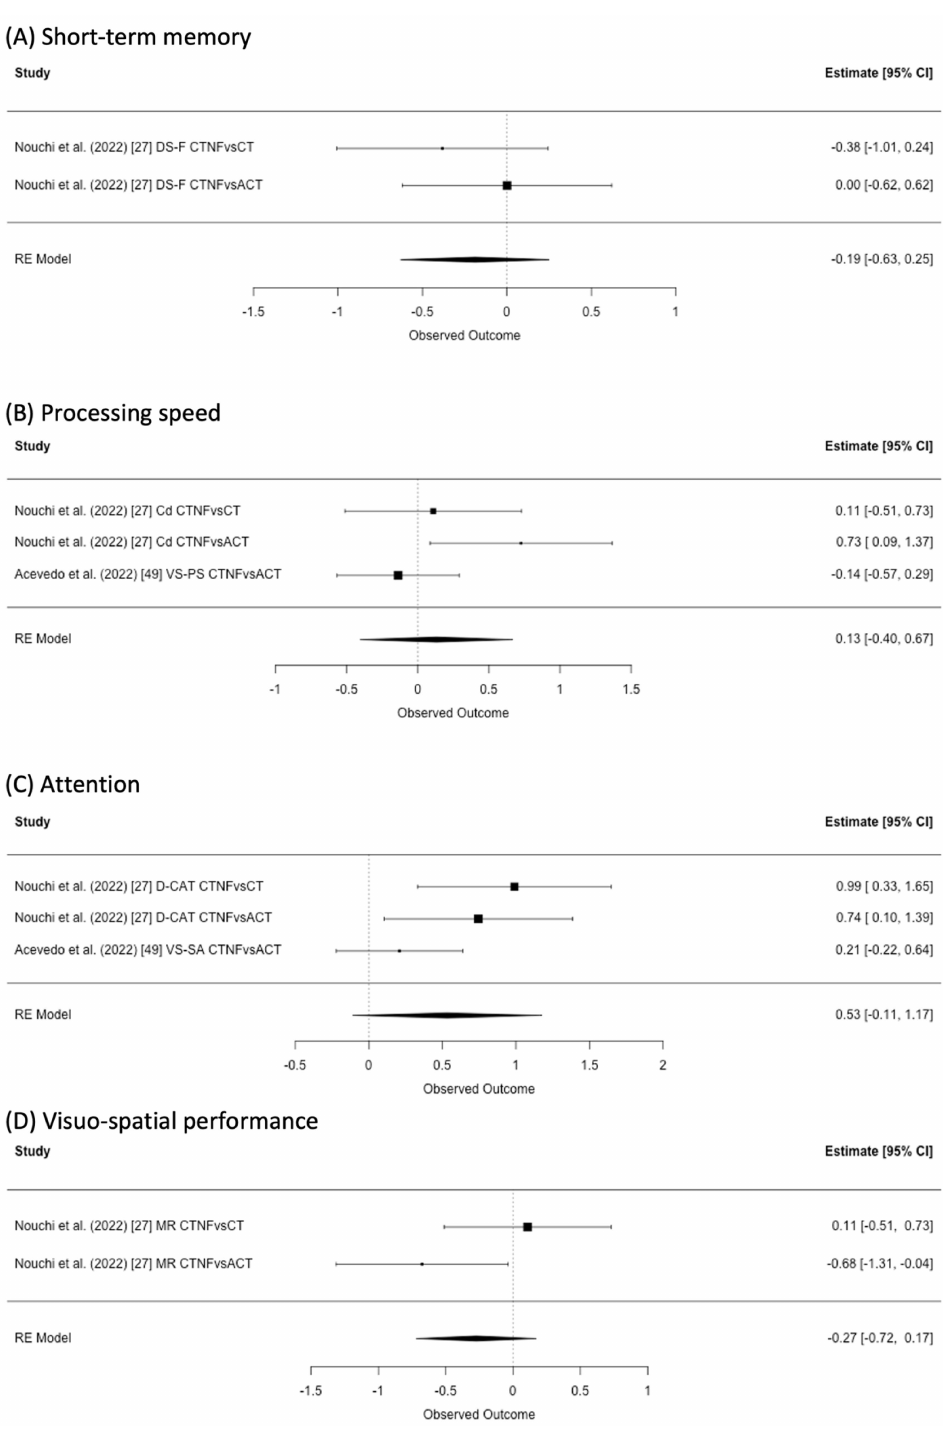
Figure 3. Effect estimates and forest plot of cognitive training with neurofeedback (CTNF) on ( A ) short-term memory, ( B ) processing speed, ( C ) attention, and ( D ) visuo-spatial performance. CT: cognitive training, ACT: active control, DS-F: digit span forward, Cd: digit symbol coding, VS-PS: CNS vital sign processing speed, D-CAT: digit cancellation task, VS-SA: CNS vital sign sustained attention, MR: mental rotation